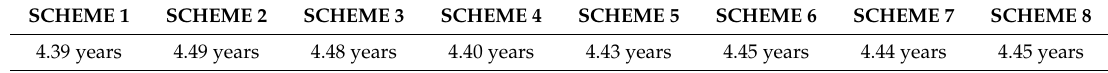
Table 7. SPB upon varying the plant